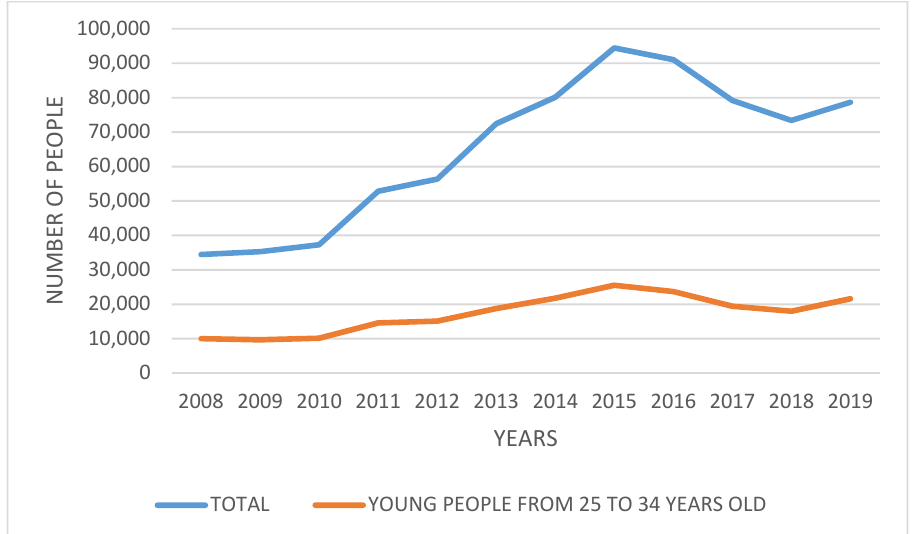
Figure 1. Spanish emigration and Spanish youth emigration (25–34 years old) during the period 2008–2019. Source: compiled by the authors based on data from the Spanish National Statistics Institute (Instituto Nacional de Estadística 2019).